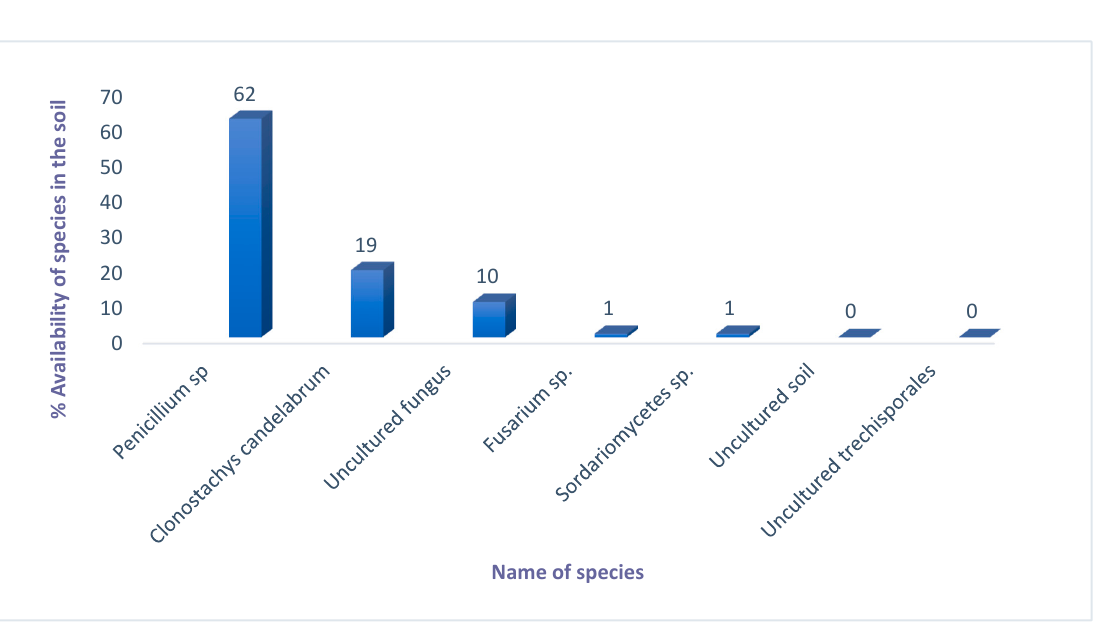
Figure 4. Representation of fungal species in non- Burkea soils.